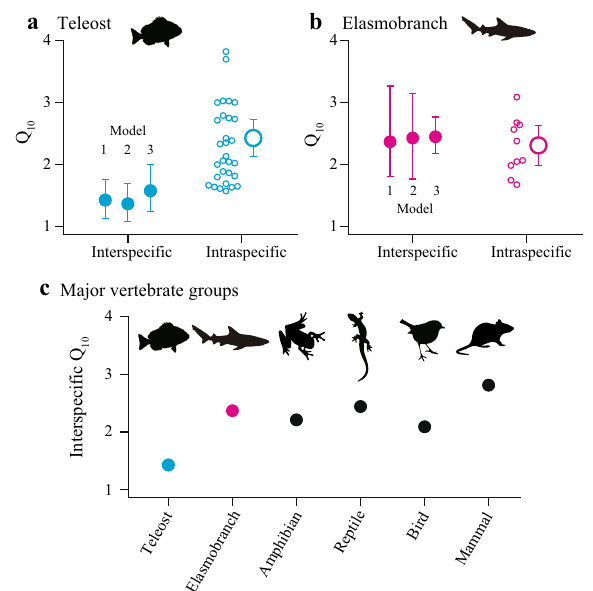
Fig. 3 | Among- and within-species thermal sensitivity (Q 10 ) of resting meta- bolic rates can differ. a , b Interspeci fi c Q 10 (with 95% con fi dence interval) esti- mated from the coef fi cient of the temperature term of three phylogenetic regression models (Models 1 – 3) compared to intraspeci fi c Q 10 (shown for each species and as the mean and 95% con fi dence interval) for a teleosts and b elasmobranchs. Models 1 – 3 are a phylogenetic generalized least squares (PGLS) model,aPGLSmodelwithspecies ’ lifestyleastheadditionalpredictorvariable,and aphylogeneticmixedmodel,respectively(Methods).Intraspeci fi cQ 10 ofteleostsis positively skewed, and an outlier (5.4) is not shown. Sample size for teleosts a : 100 species for all models of interspeci fi c Q 10 , 31 species for intraspeci fi c Q 10 . Sample size for elasmobranchs b : 34 species for Models 1 and 2 and 377 estimates for Model 3 of interspeci fi c Q 10 , 10 species for intraspeci fi c Q 10 . c A comparison of interspeci fi cQ 10 ofrestingmetabolicratesacrossmajorvertebrategroups.Datafor teleostsandelasmobranchsarefromthisstudyand dataforothergroupsarefrom White et al. 11